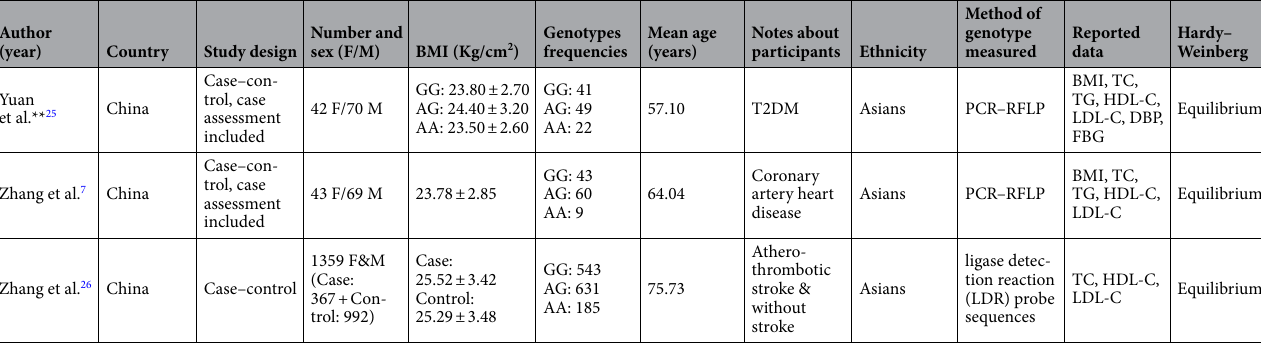
Table 1. Characteristics of studies that were included in this systematic review and meta-analysis. F female, M male, NM HNW, Healthy normal weight, HO Healthy obesity, not mention, HTN hypertension, T2DM type 2 diabetes mellitus, GDM gestational diabetes mellitus, PCR polymerase chain reaction, PCR-CTPP Polymerase chain reaction with confronting two-pair primers, PCR–RFLP polymerase chain reaction-restriction fragment